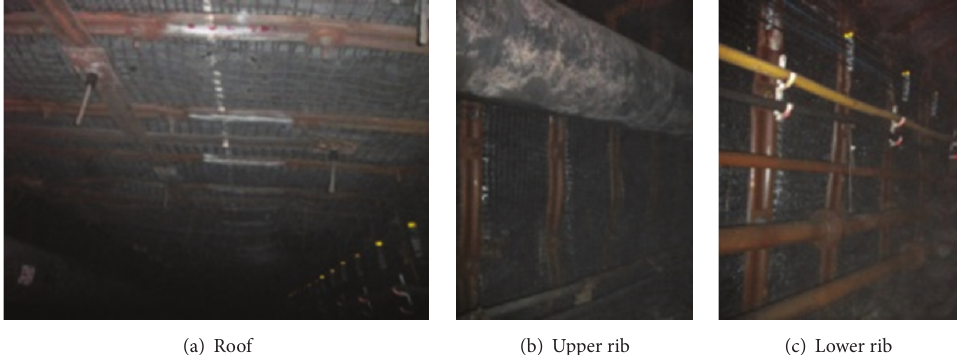
Figure 19: Roadway conditions after final